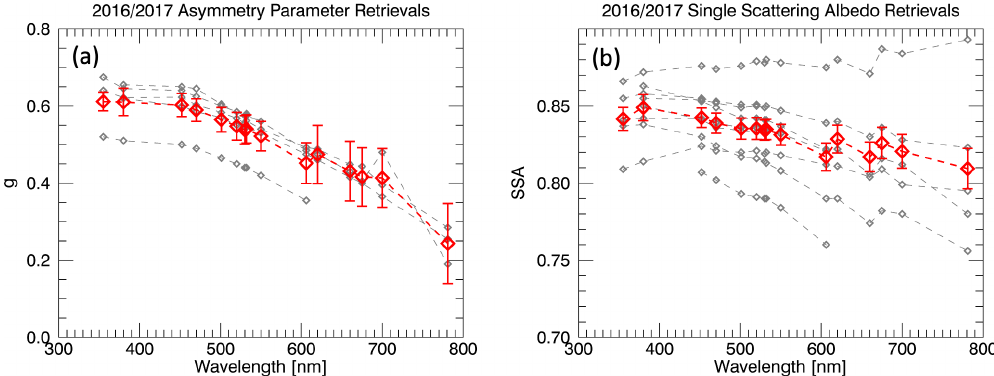
Figure 3. Retrieved (a) asymmetry parameter and (b) SSA spectra for 2016 and 2017 successful retrievals. The red spectrum indicates the mean retrieved values with associated error bars; the grey spectra are the individual retrievals. Table 3. Mean retrieved SSA (row 3) and g (row 5) spectra along with their associated standard deviations ( σ ) (row 4 and row 6, respectively). The second row provides the number of valid retrievals for that wavelength. As described in C19, individual wavelengths can fail within the retrieval, resulting in fewer valid retrievals than valid cases (e.g., 355nm SSA has five valid retrievals despite having nine valid cases). Wavelength 355 380 452 470 501 520 530 532 620 660